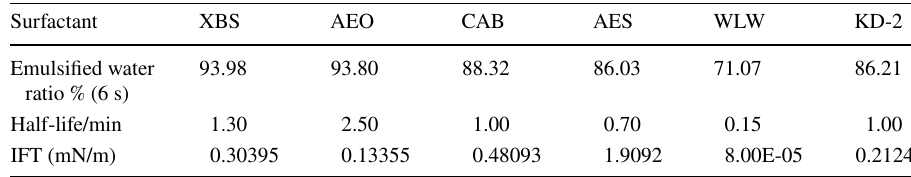
IFT measurements results of different